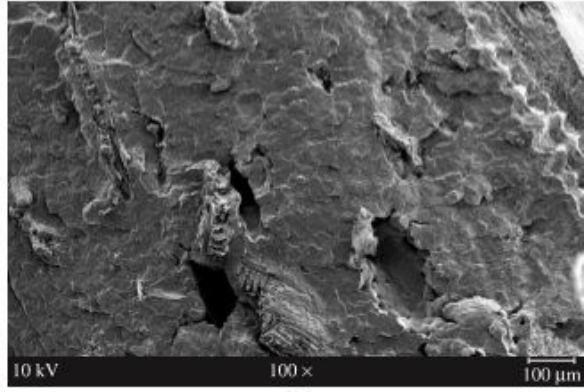
Figure 19: SEM image of 20% RH (with compatibilizer) reinforce polypropylene showing presence of voids [10]